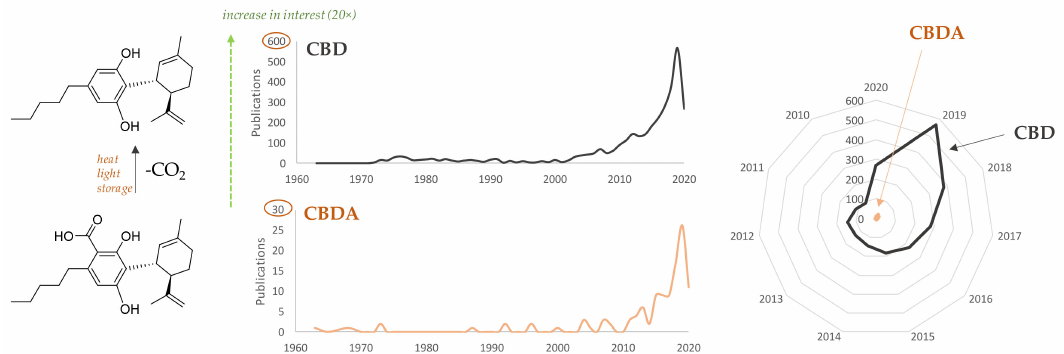
Figure 2. Number of papers dealing with the concept “CBD” or “CBDA” published in year range 1960–2020 (source: PubMed database, 18 April 2020). Data are plotted also through a radial chart that enhances, at one glance, the di ff erent interest in the two highly related compounds.